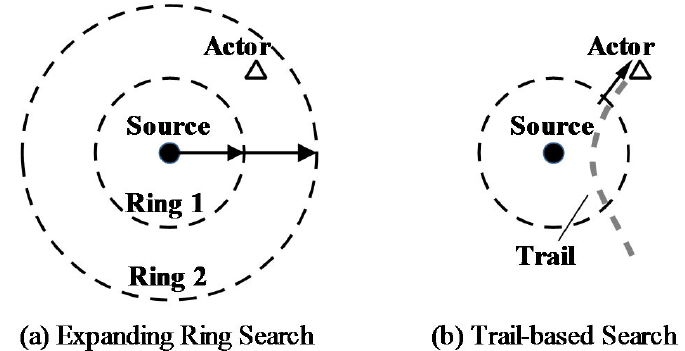
Figure 1. Expanding Ring Search and Trail-based